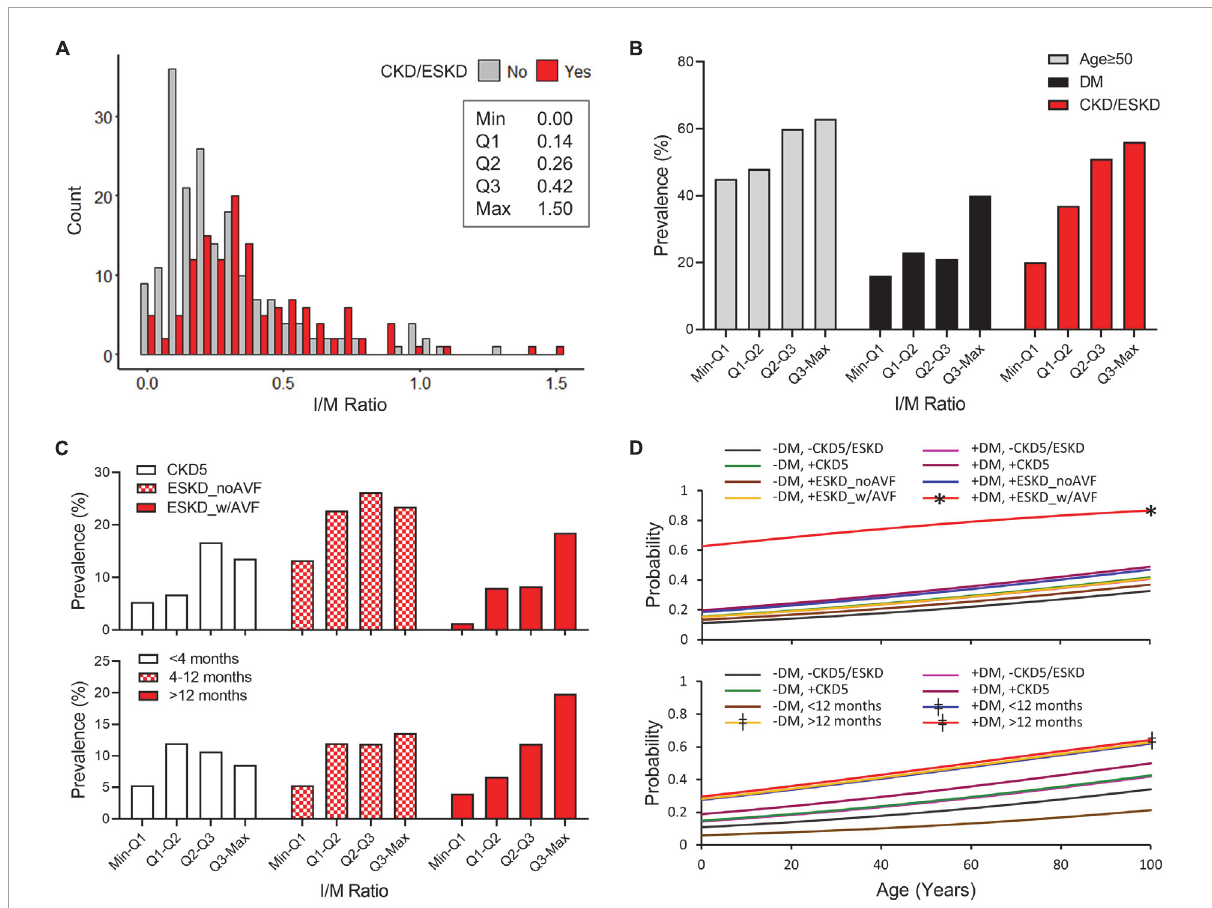
FIGURE1 Predictors of high intimal hyperplasia (IH) in CKD and non-CKD veins. (A) Histogram of IH expressed as intima/media area ratio in CKD/ESKD and non-CKD veins. The minimum, first quartile (Q1), median (Q2), third quartile (Q3), and maximum values are indicated for the overall study cohort. (B) Prevalence of age ≥ 50 years, diabetes, and CKD/ESKD per quartile of IH in the overall study cohort. (C) Distribution of CKD and ESKD subgroups per quartile of IH according to disease stage and vascular access history (Top) or dialysis vintage (Bottom). (D) Probability of IH falling in the upper quartile values ( ≥ 0.42) as predicted by age and combined status of diabetes and CKD/ESKD stages. CKD subgroups are separated according to disease stage and vascular access history (Top) or dialysis vintage (Bottom). DM, diabetes; CKD5, stage 5 CKD; ESKD_noAVF, ESKD without previous AVF or AVG; ESKD_w/AVF, ESKD and previous AVF/AVG history. ∗ p < 0.05 vs. all individual models, ‡ p < 0.05 vs. (–) DM/(–)CKD5/ESKD and (–) DM/ < 12 months.